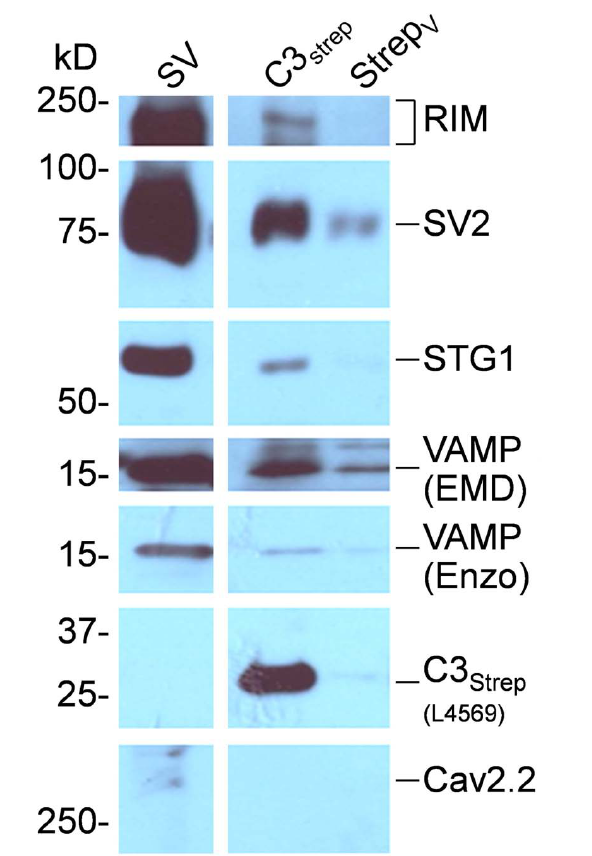
FIGURE 6 | SV capture by the CaV2.2 distal C-terminal. C3 strep was immobilized on beads and used for SV-PD.The fusion protein is identified on theWB by L4569, an antibody raised against the distal end of the long-splice C-terminal region, but is negative for the control expressed vector lane (Strep V ). C3 strep SV-PD was evident from the much darker SV protein bands than observed in the control lane. C3 s trep SV-PD: N RIM = 9; N STG1 = 6; N SV2 = 7. In this example a trace amount of CaV2.2 was observed in the SV